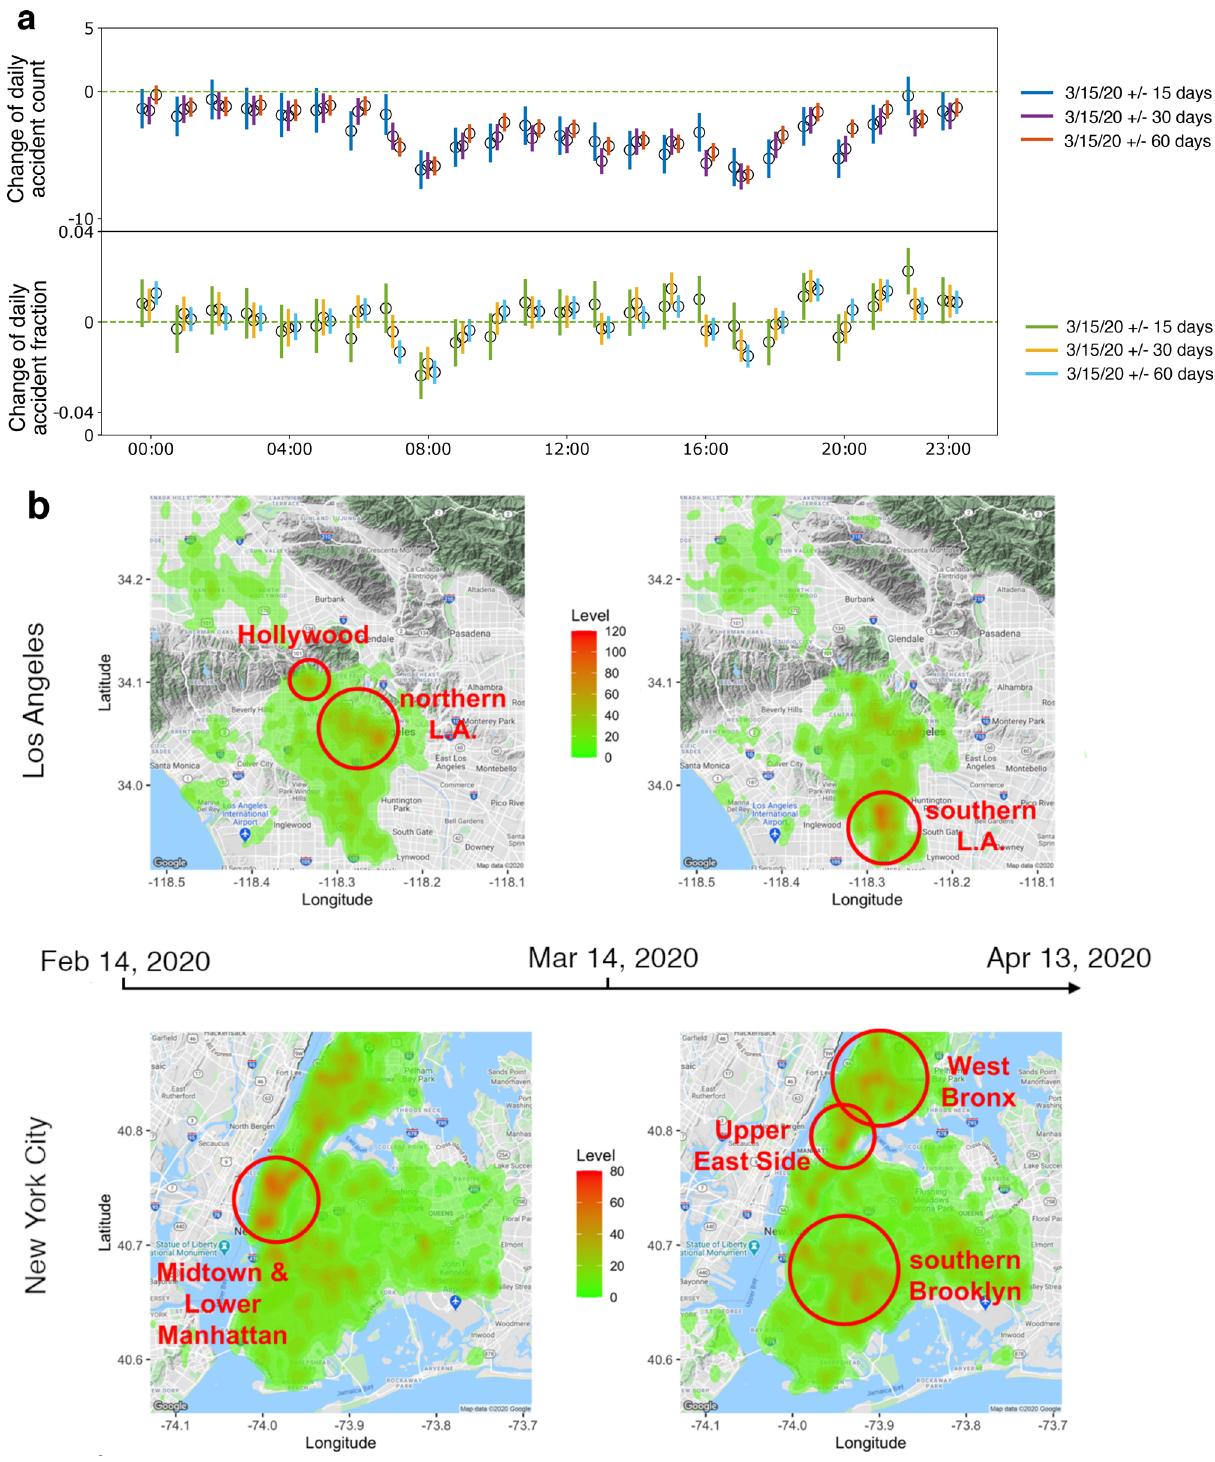
Figure 3. Temporal and spatial shifts of accident hot spots. ( a ) Change of daily accident counts (top) and fractions (bottom) grouped by different hours of a day in NYC. 95% confidence intervals are shown as vertical bars for each data point. Also shown are estimates from three time windows: 15 days (blue and green), 30 days (purple and orange), and 60 days (red and cyan) before and after the mobility change-point. ( b ) Heatmap of traffic accidents in LA (top) and NYC (bottom) between Feb. 14, 2020 and Apr. 13, 2020, using Mar. 15 2020 as the mobility change-point. The maps are produced by R package ggmap 3.0.0 (github.com/dkahle/ggmap) and Google Map service